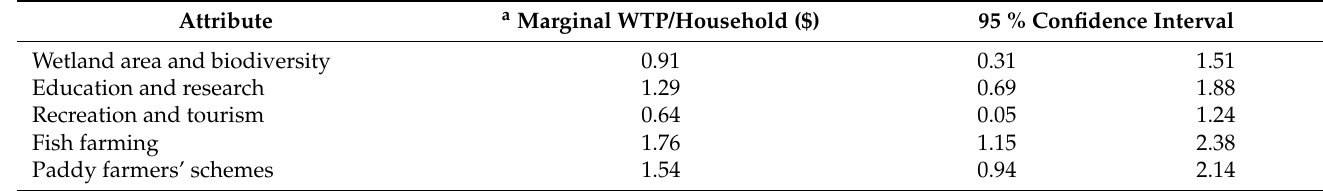
Table 6. Marginal willingness to pay for wetland management attributes per